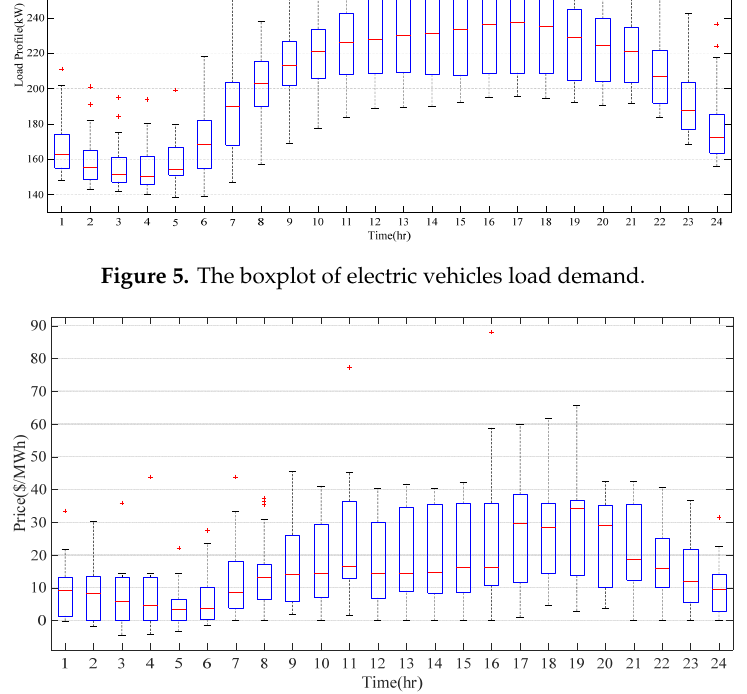
Figure 6. The boxplot of hourly electricity price.